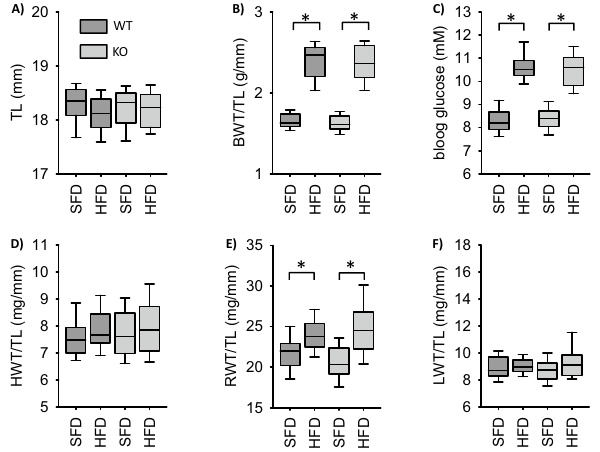
Figure 1. Influence of high fat diet on body weight ( A , B ), blood glucose ( C ) and heart ( D ), kidney ( E ) and lung ( F ) weight in EC-EGFR-WT and EC-EGFR-KO animals. Number of animals of the EC-model: N(WT, SFD) = 29, N(WT, HFD) = 30, N(KO, SFD) = 38, N(KO, HFD) = 39. Number of animals of the VSMC-model: N(WT, SFD) = 44, N(WT, HFD) = 38, N(KO, SFD) = 58, N(KO, HFD) = 54.*p < 0.05. SFD standard diet, HFD high fat diet, BWT body weight, TL tibia length, HWT heart weight, RWT renal weight, LWT lung weight, VSMC vascular smooth muscle